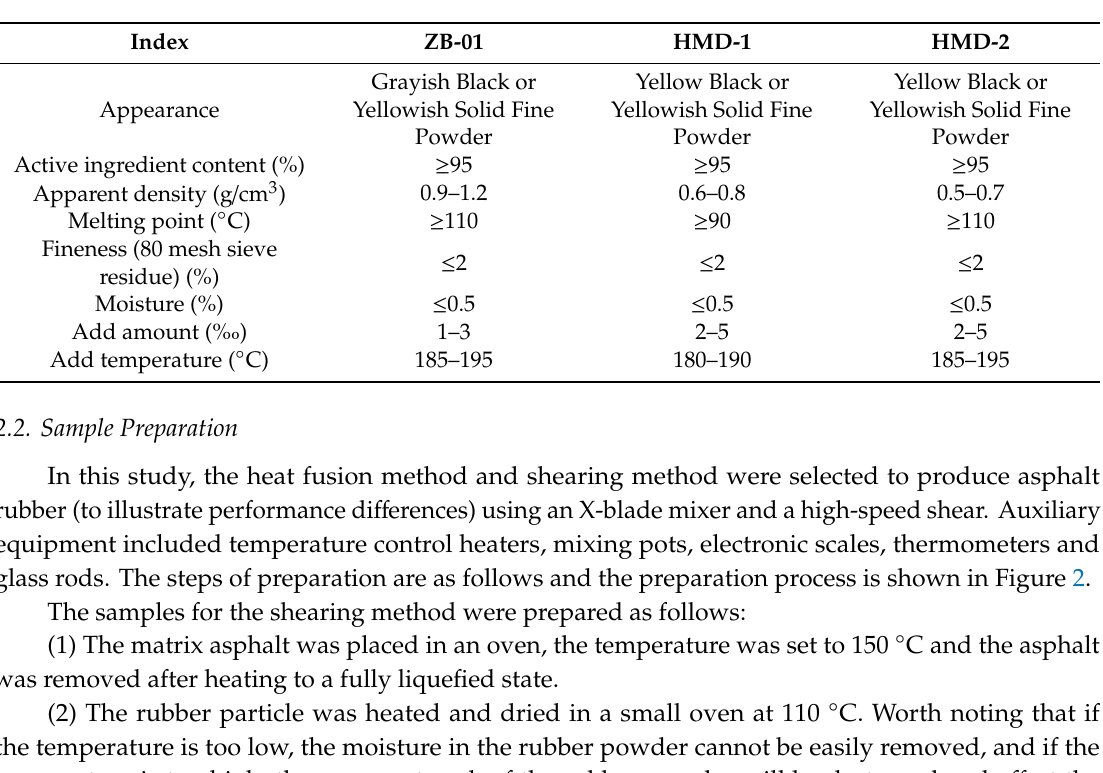
Table 4. Parameters of di ff erent